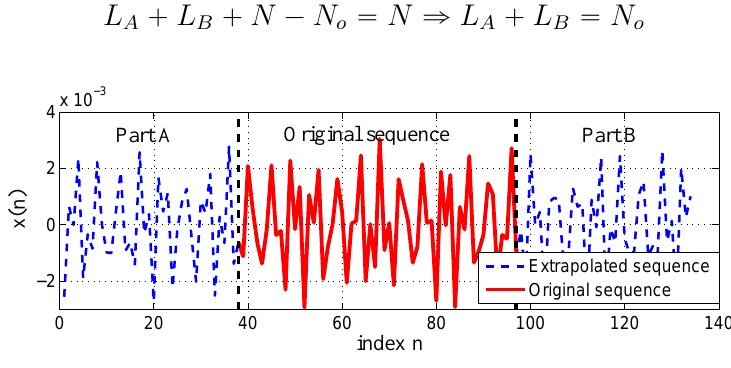
Figure 1. Original sequence and its extrapolated